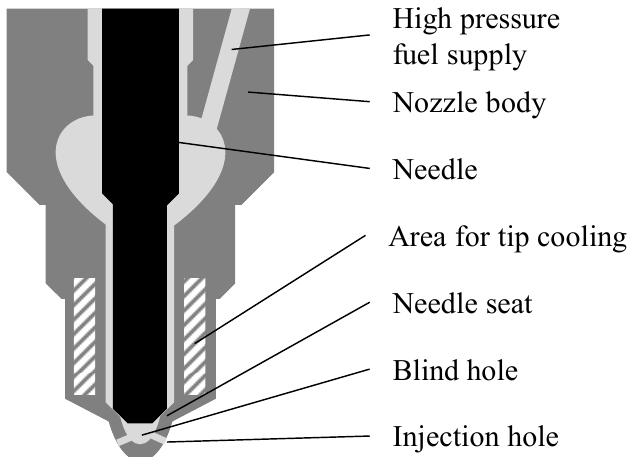
Figure 1. Design of an injection nozzle, based on Zeh and Okumu ş o ğ lu [41].